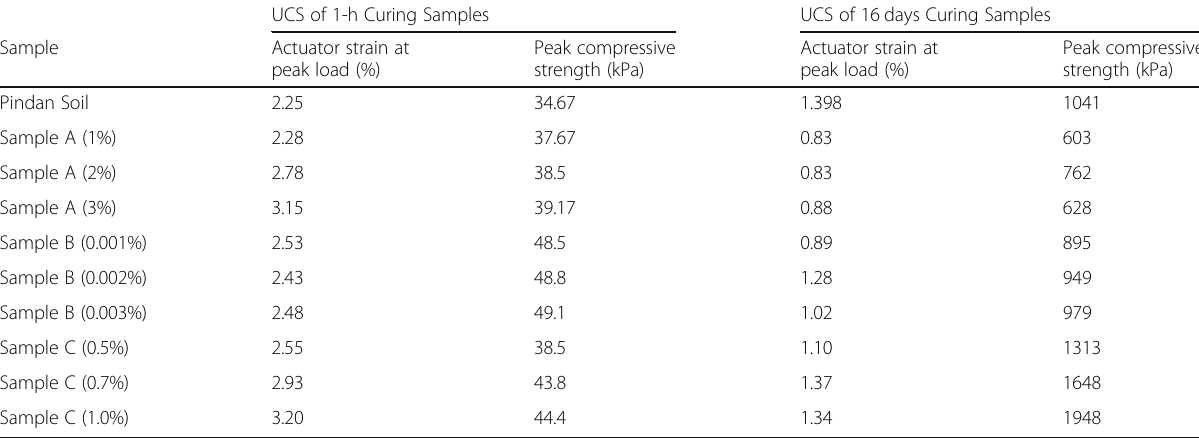
Table 6 Averages of UCS Results for the 1-h and 16 days cured samples UCS of 1-h Curing Samples UCS of 16 days Curing Samples